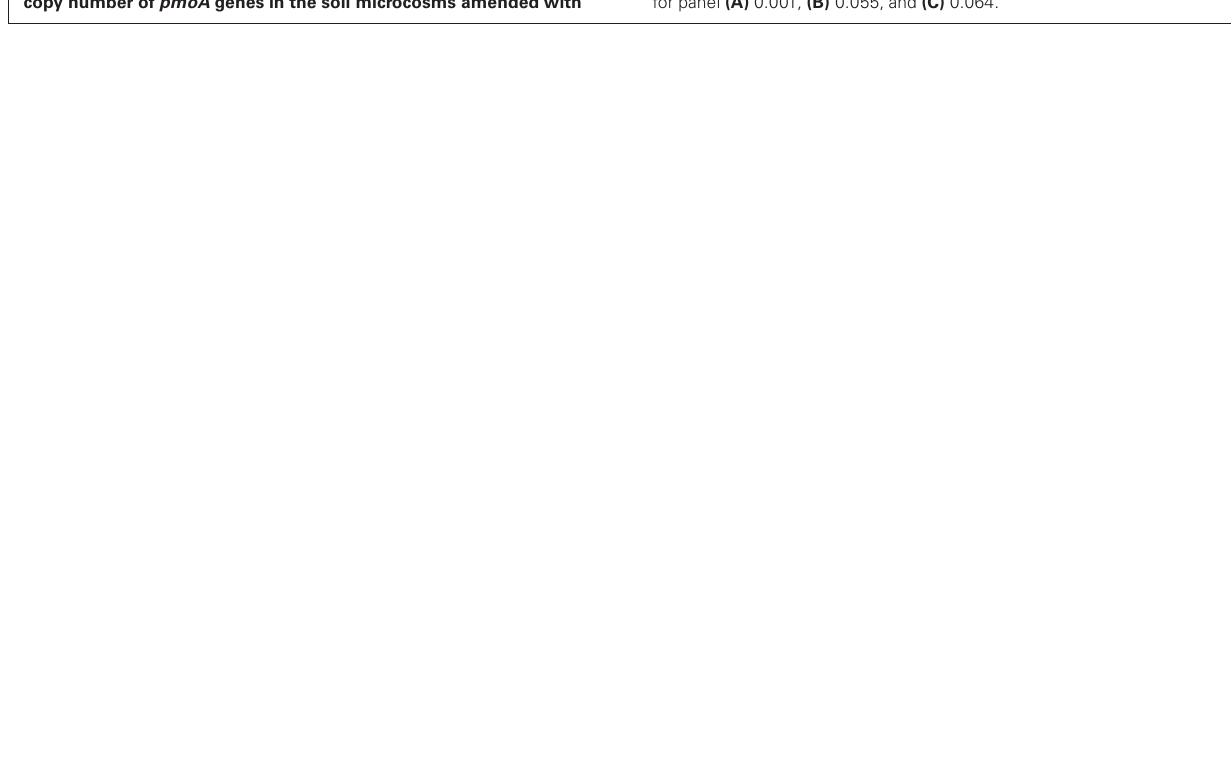
FIGURE A1 | Relationships among the concentration of CH 4 remained in the headspace, the amount of NO − 2 and NO − 3 -N and the copy number of pmoA genes in the soil microcosms amended with